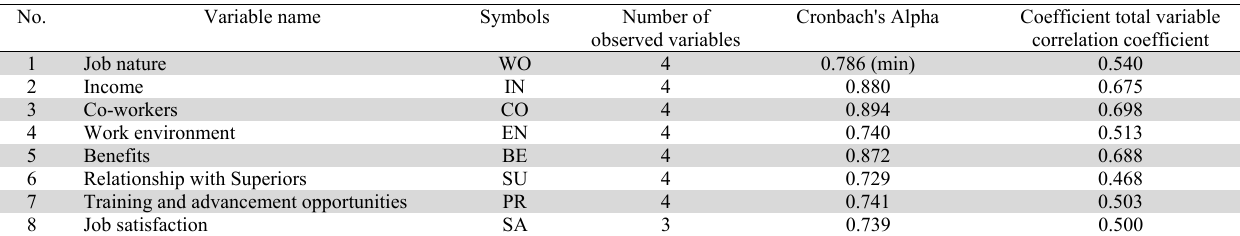
Test results of the